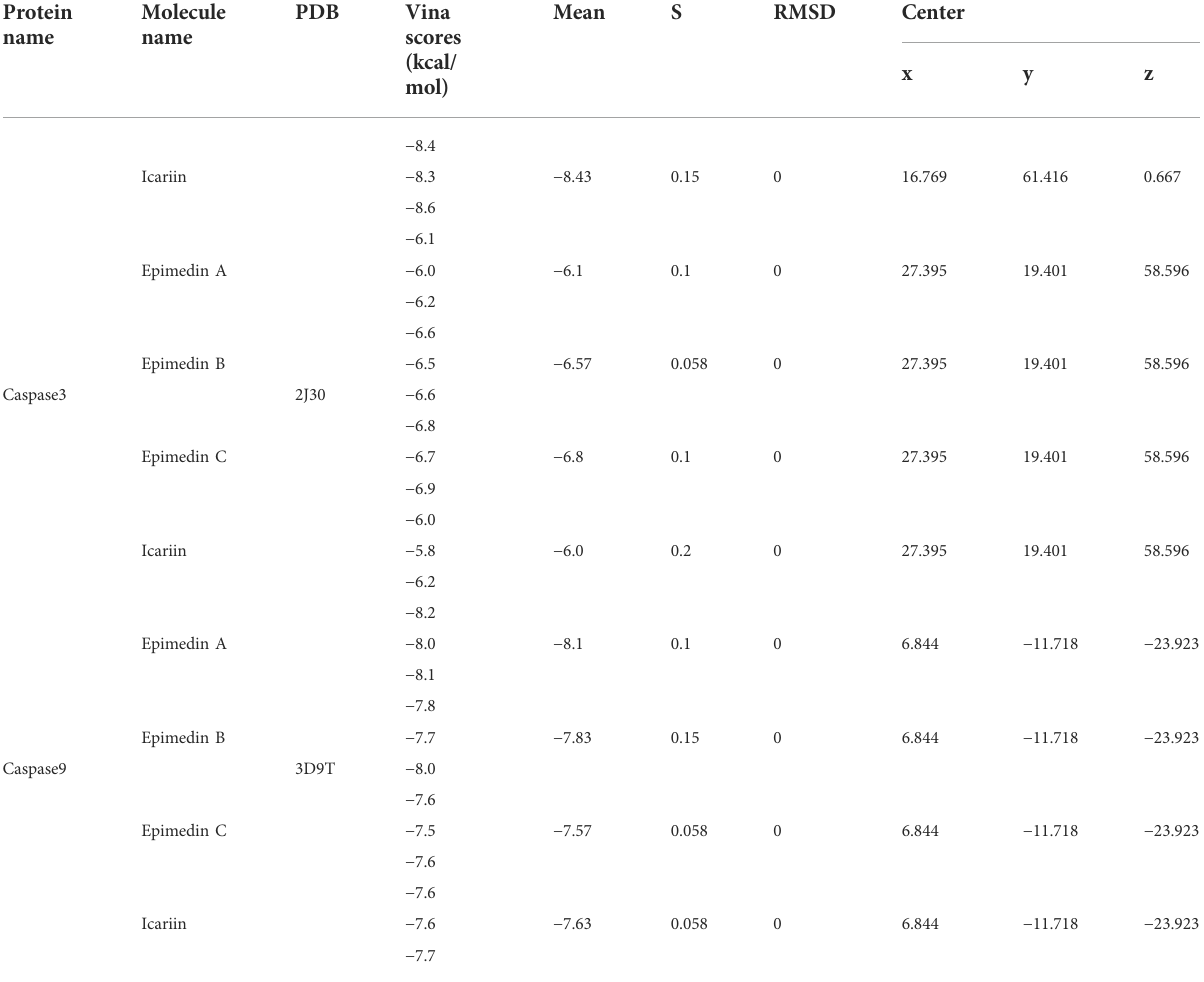
Figure 5A, NF- κ B p65 had almost no fl uorescence expression in the intestinal tissues of normal mice but was highly expressed in cisplatin-treated mice ( p < 0.01). Interestingly, the intensity